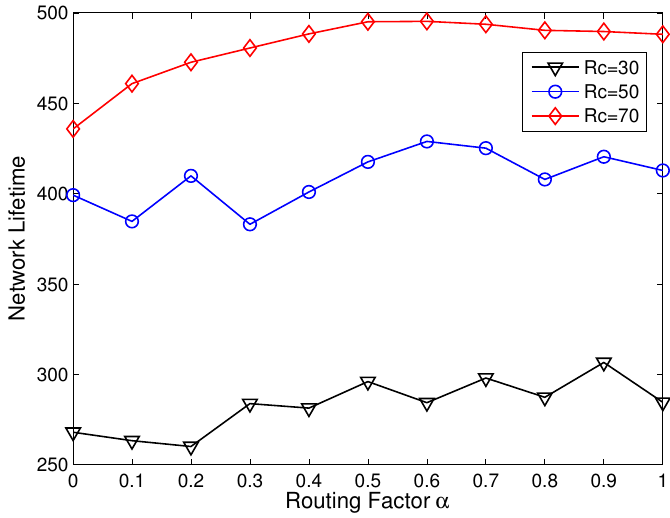
Figure 5. Network lifetime with different routing factor α and clustering range R